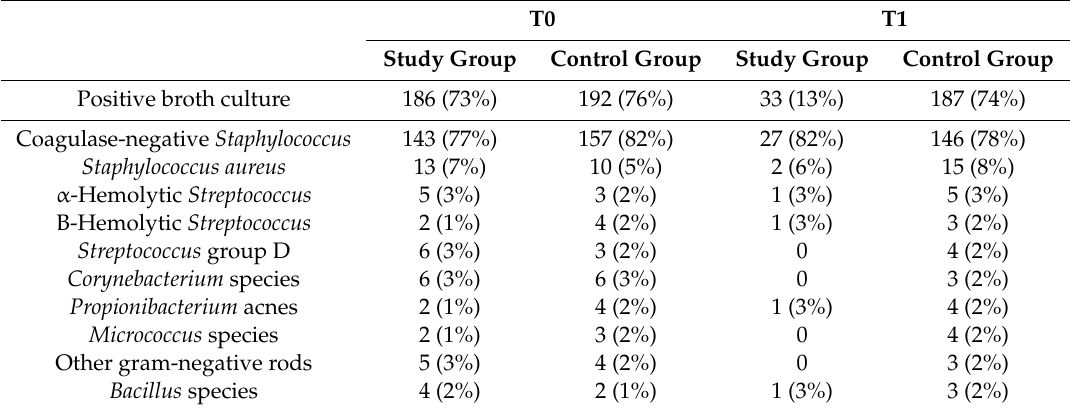
Table 3. Isolated bacteria from the conjunctival swab.